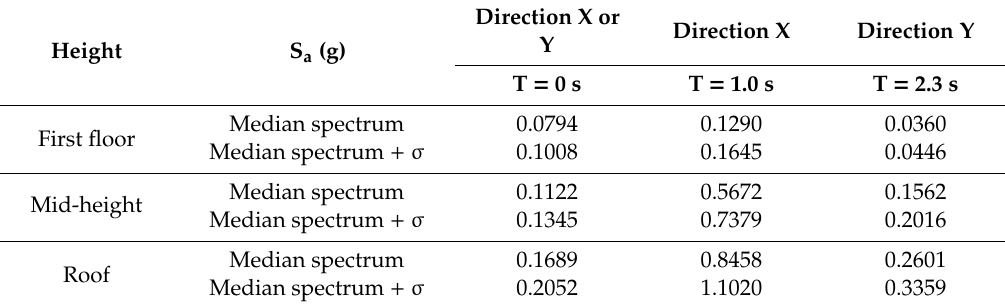
Table 2. Spectral absolute acceleration values for RP = 140 years for three periods of interest.